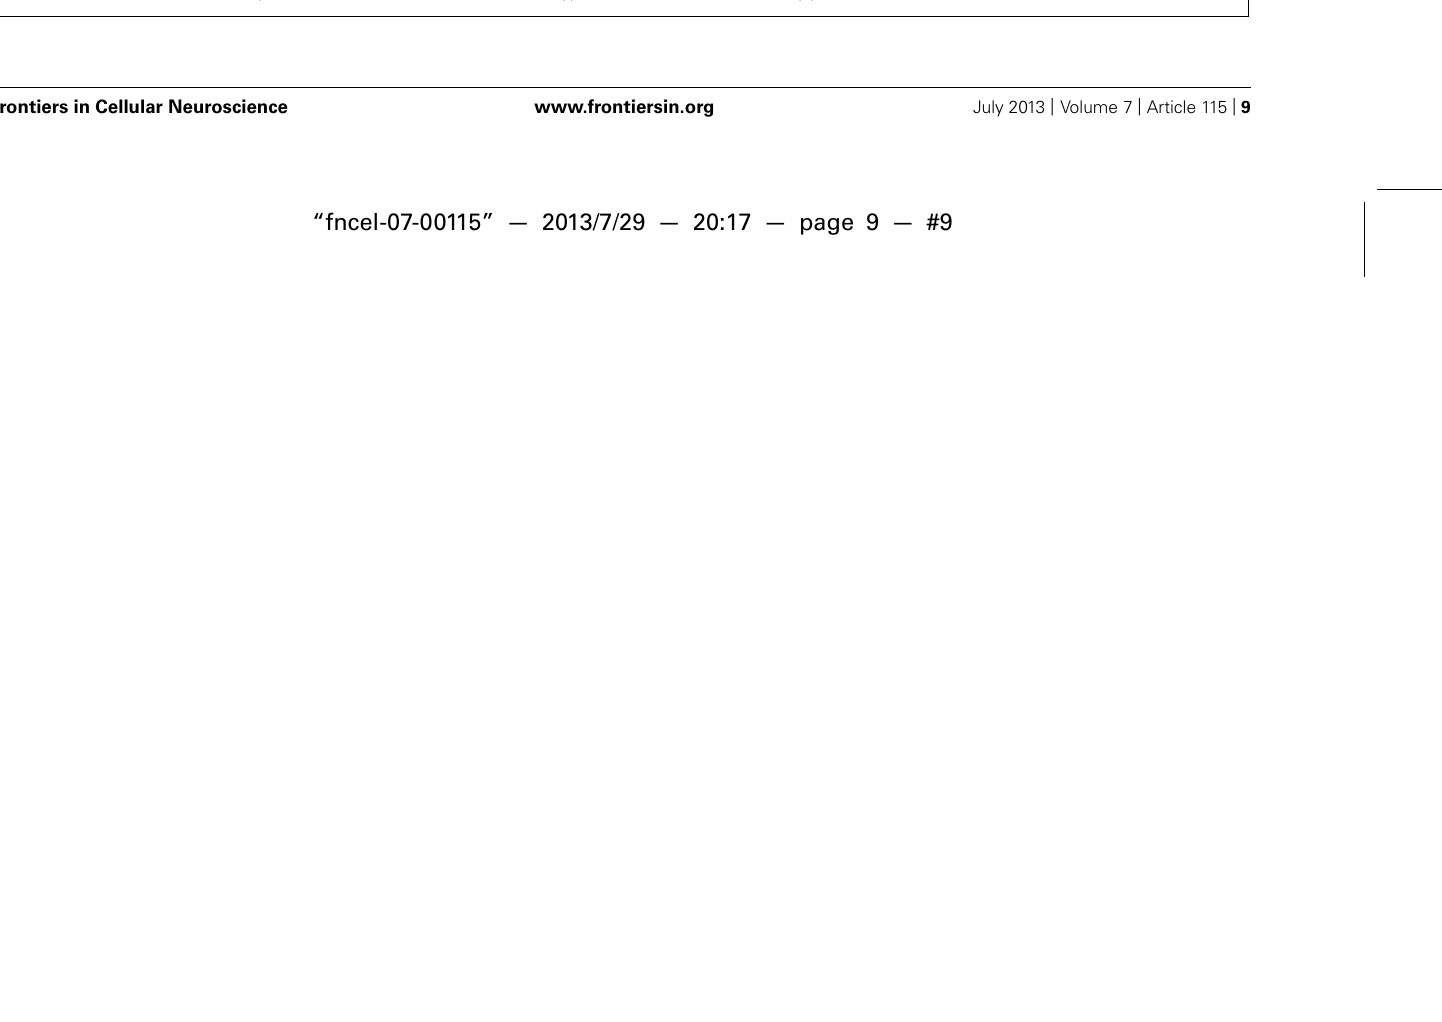
of GABA-A receptors with different functions. Post-synaptic GABA-A receptors, which are pentameric chloride channels composed of 2 α 2 βγ subunits, mediate the phasic portion of GABAergic inhibition, while extrasynaptic GABA-A receptors, pentamers composed of 2 α 2 βδ subunits, primarily contribute to tonic inhibition in the hippocampus. Neurosteroids activate both synaptic and extrasynaptic receptors and enhance the phasic and tonic inhibition, and thereby promote maximal network inhibition in the